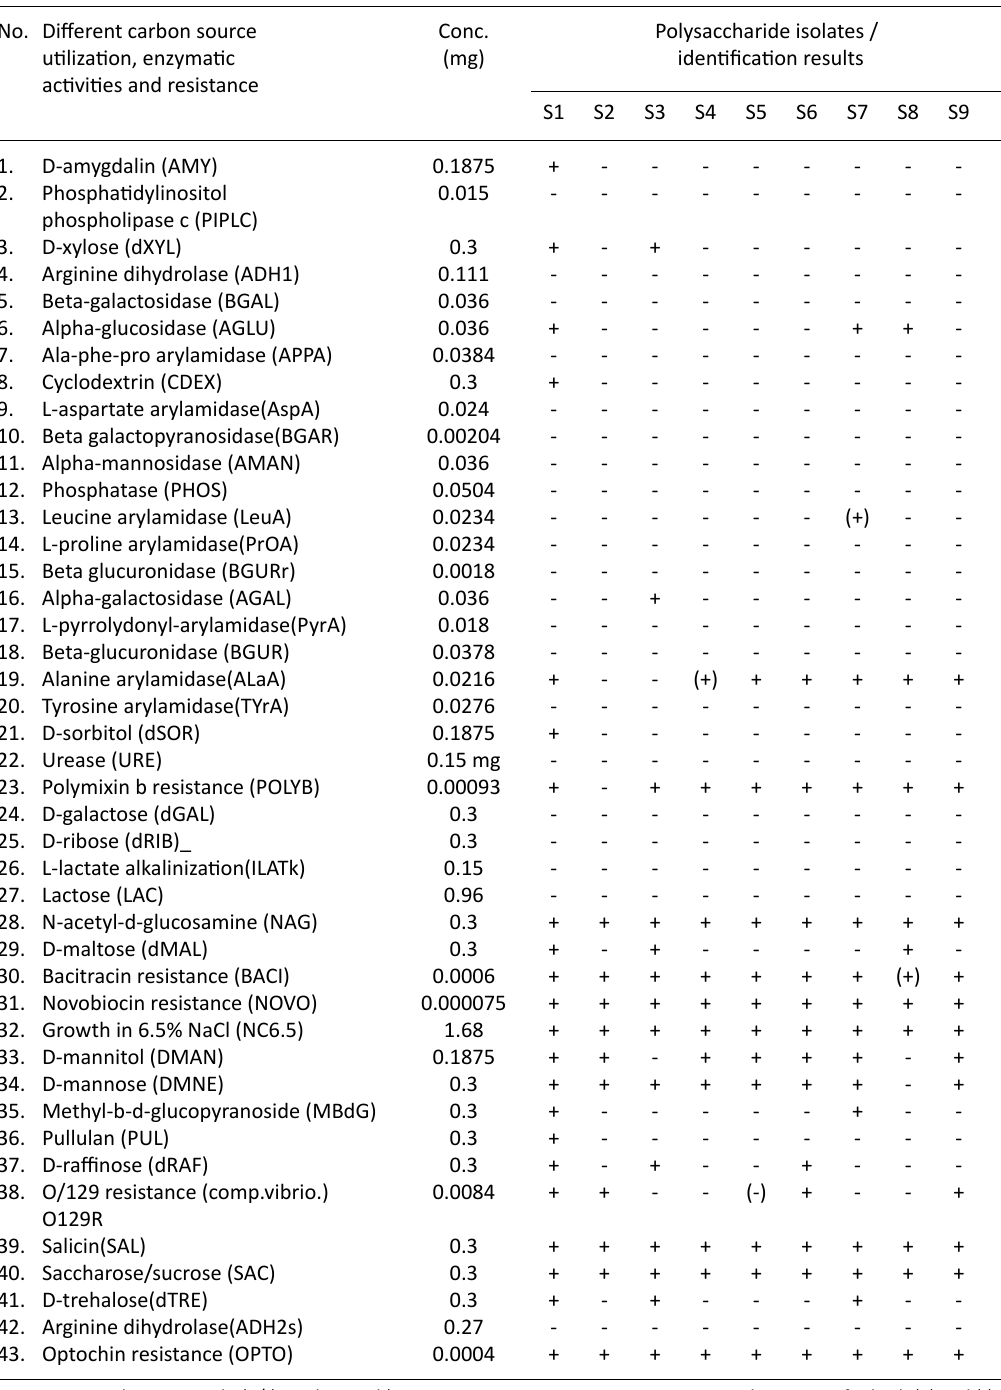
Table 3. Biochemical tests according to Biomיrieux Vitek for the selected promising EPS producing isolates.